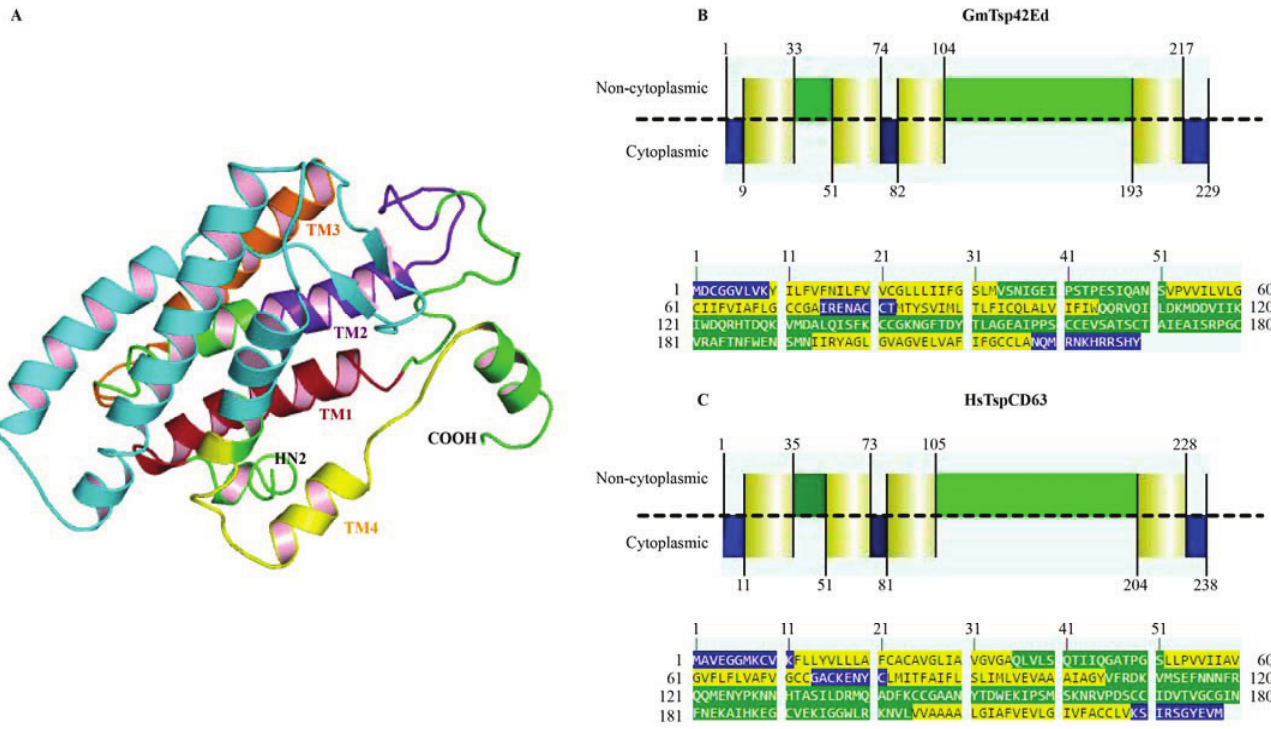
Figure 4. Cartoon representation of the modeled GmTsp42Ed structure: ( A ) 3-D representation of GmTsp42Ed model, in which the N- and the C-termini are shown as NH2 and COOH, respectively. The four transmembrane domains are color-coded as red, purple, orange and yellow for TM1 to TM4, respectively. The LEL domain which is located between TM3 and TM4 has three (cid:3)-helices and two anti-parallel (cid:4)-strands and is shown in cyan; ( B , C ) 2-D representation of the orientation of the cytoplasmic (shown in blue), non-cytoplasmic (small extracellular loop (SEL) and LEL domains) (shown in green), and TM1-4 helices (shown in yellow) of G. morsitans GmTsp42Ed and the human tetraspanin (HsTspCD63), respectively. The alignments of GmTsp42Ed and HsTspCD63 are shown at the bottom of the domain orientations. The dotted lines in Panels ( B ) and ( C ) represent a hypothetical cellular plasma